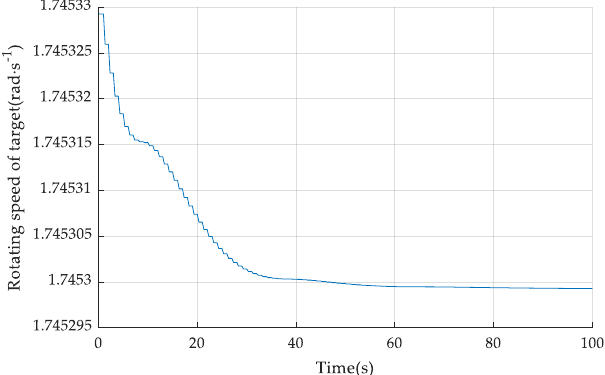
Figure 16. Target speed curve in conventional mode.